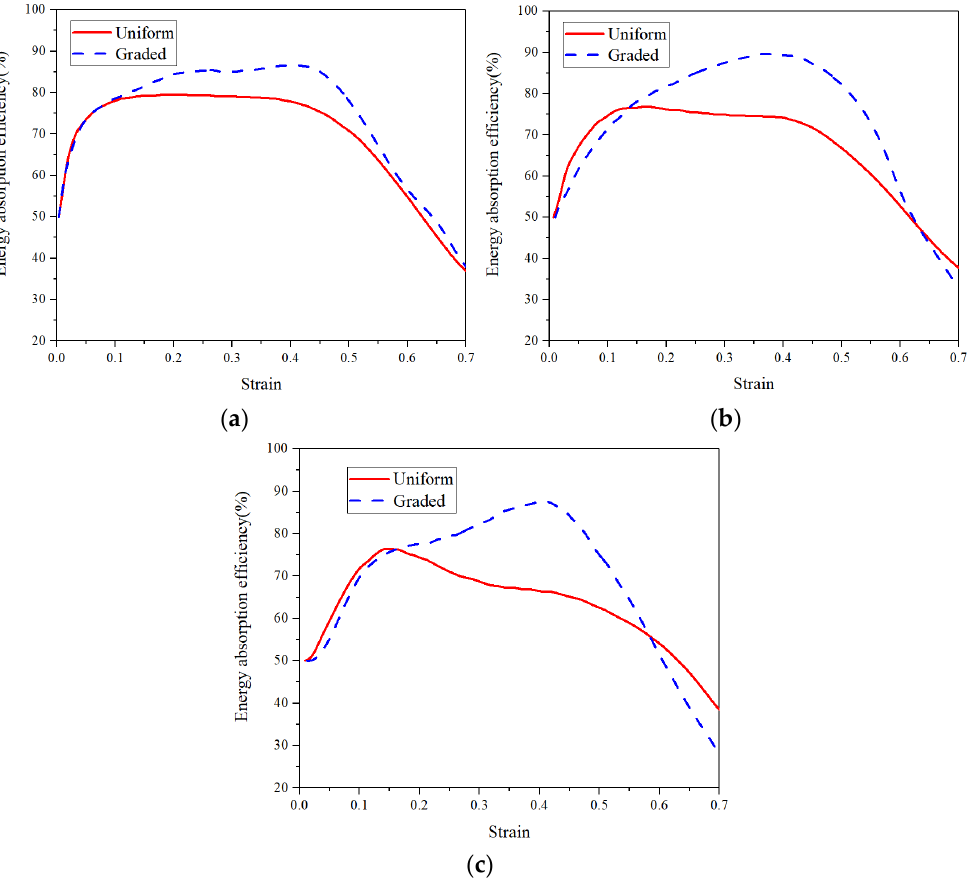
Figure 11. Energy absorption efficiency versus compressive strain curves of uniform and graded CCCFS at the temperature of ( a ) 25 °C , ( b ) 300 °C, and ( c ) 500 °C . The onset strain of densification ε d at which η max is reached, the initial compressive modulus, plateau stress, effective energy absorption W e (i.e., W e = (cid:1516) 𝜎𝑑𝜀 maximum energy absorption efficiency η max of both uniform and graded CCCFs at different temperatures are all listed in Table 1. The uniform CCCF with a larger relative density is superior to the graded CCCF with a small relative density, in terms of both the initial compressive modulus and plateau stress. However, the effective energy absorption W e and the maximum energy absorption efficiency η max of the graded CCCF are both larger than those of the uniform CCCF, attributed to the much larger onset strain of densification 𝜀 (cid:3031) for the foam with gradient pore arrangement. Moreover, the high temperature weakens the initial compressive modulus, plateau stress, and effective en- ergy absorption for both uniform and graded CCCFs. Nevertheless, t he onset strain of densification 𝜀 (cid:3031) and the maximum energy absorption efficiency 𝜂 (cid:3040)(cid:3028)(cid:3051) are less sensitive to the temperature, especially for the graded CCCFs . 3.3. FE Analysis